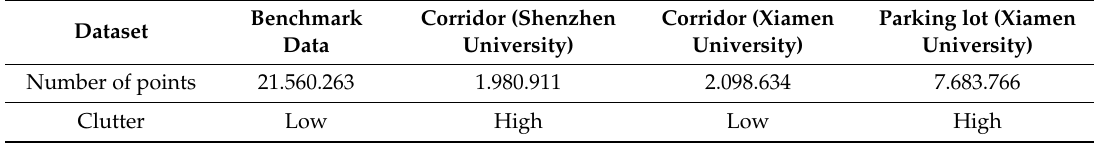
Table 2. Specifications of point clouds.